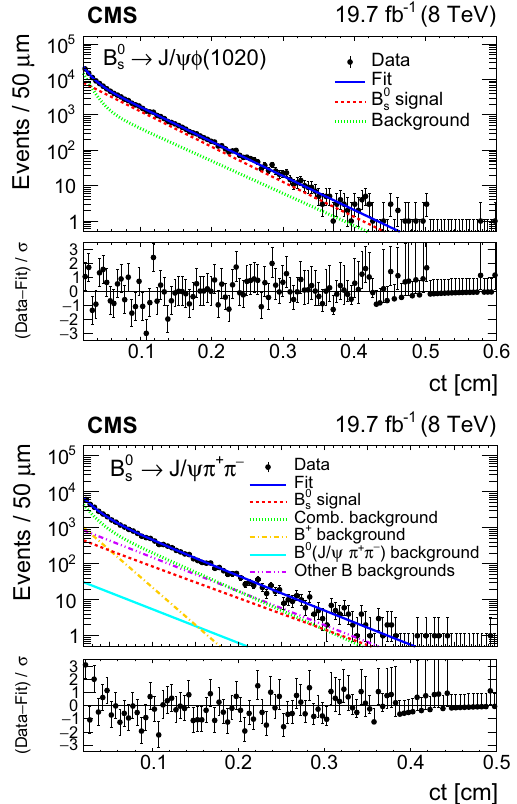
(dashed-dotted), B 0 → J /ψπ + π − contribution (dashed-dotted-dotted- dotted), and partially reconstructed and other misidentified B back- grounds (dashed-dotted-dotted) shown for the lower plots. the lower panels of the figures on the right show the difference between the observed data and the fit divided by the data uncertainty. The vertical bars on the data points represent the statistical uncertainties